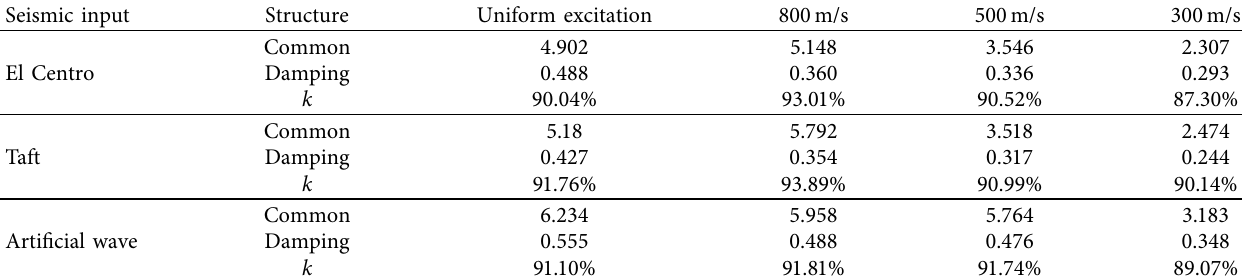
Table 6: Peak acceleration response of the top suspended floor under 9 frequent earthquakes.